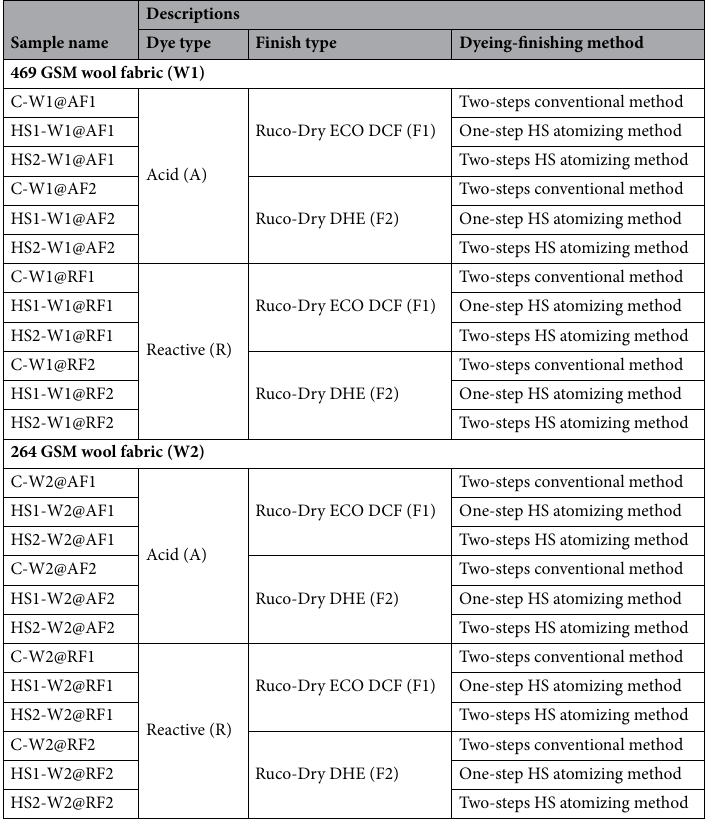
Table 1. Summary of sample name and corresponding